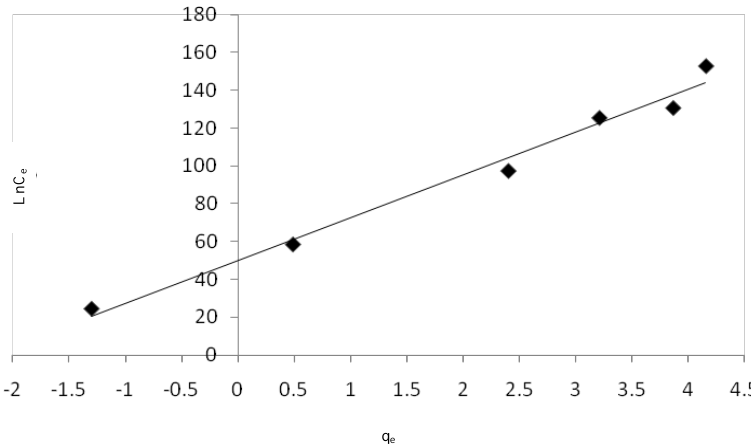
Figure 10. Temkin isotherm for adsorption data of AR18 by MWCNTs; Time 120 min, dose: 0.04 g/100 mL, pH =7.